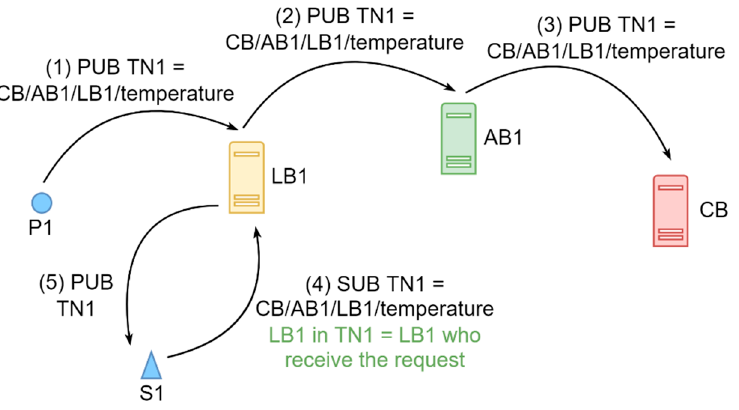
Figure 3. First communication scenario.